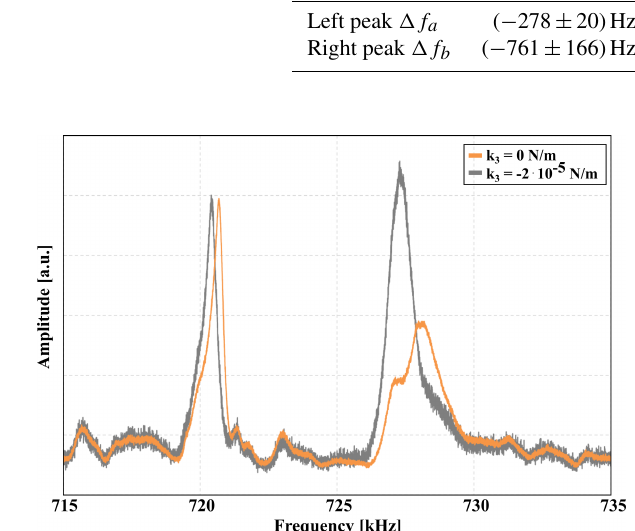
Figure 16. Amplitude response curve of the coupled system mea- sured with laser deflection at the microcantilever under high vacuum ( ≈ 10 − 5 mbar) and at room